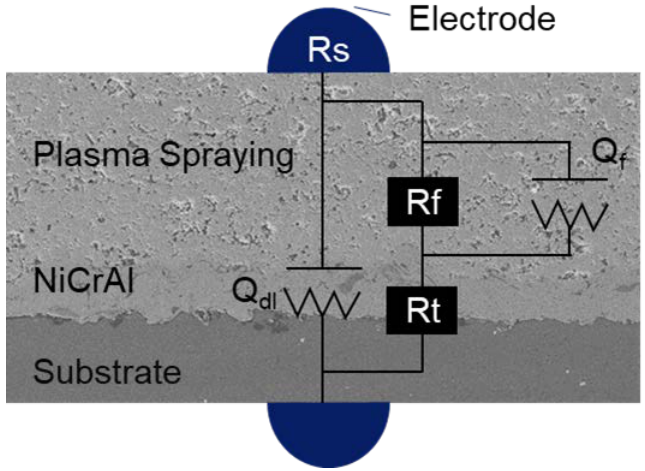
Figure 5. Alternative current impedance spectra and bode diagrams of the VW75 substrate and plasma spraying ceramic layer. ( a ) Nyquist plots; ( b ) Bode plots.